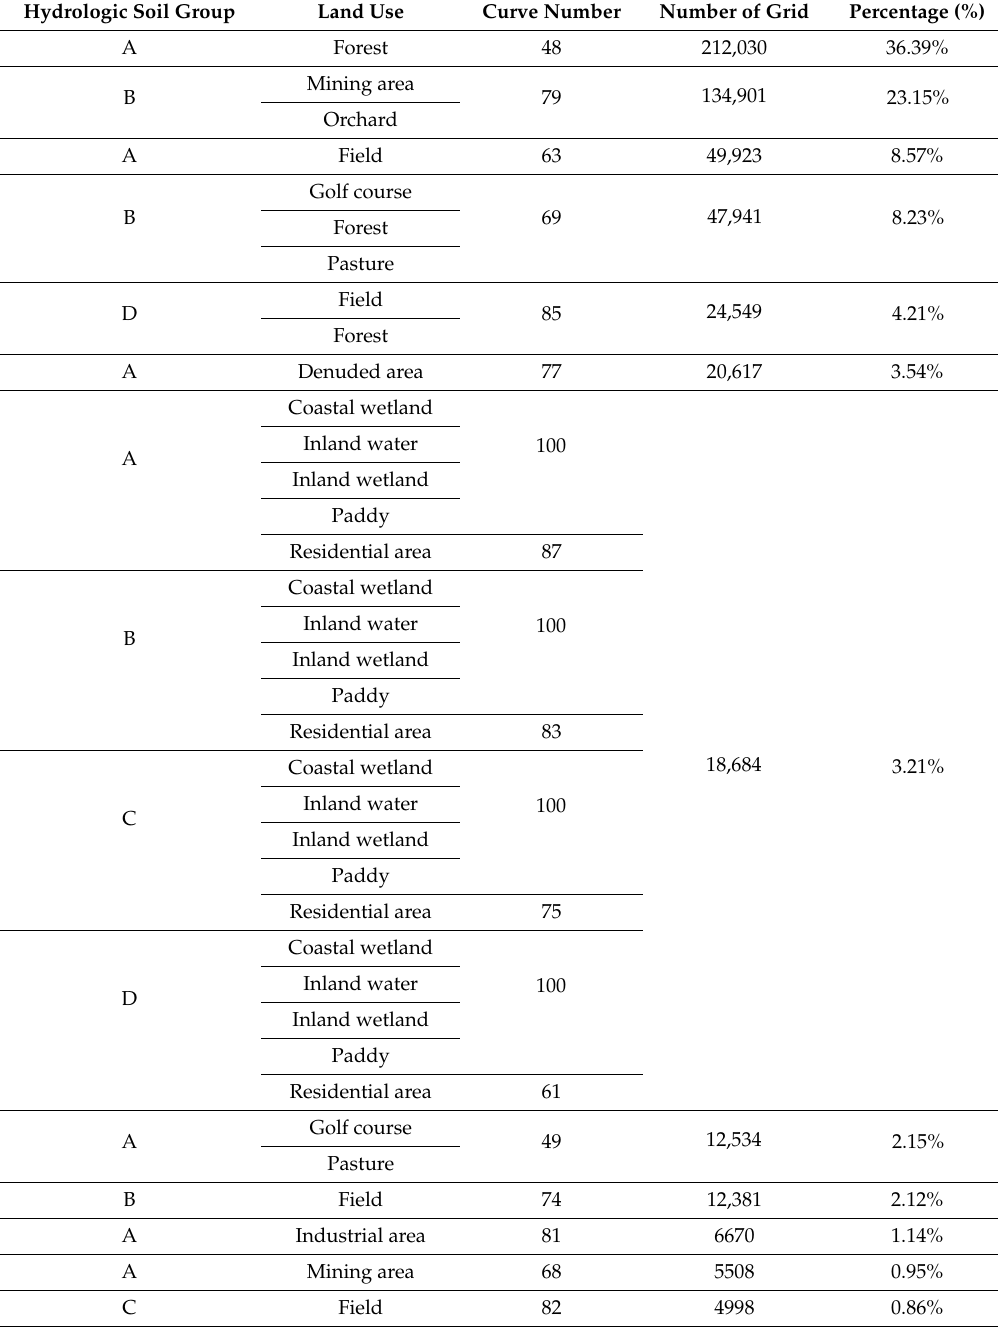
Table 1. Portion percentage of assorted soil textures and the corresponding parameters for the averaged curve